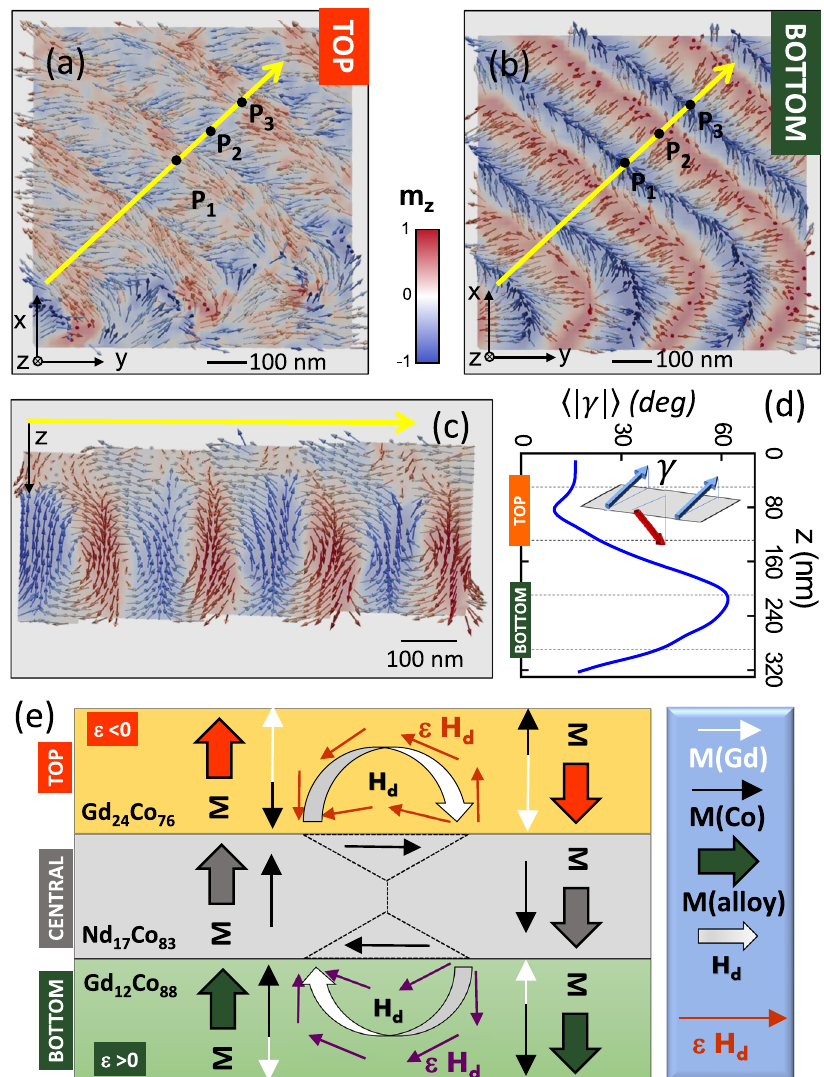
Fig. 3 Vectorial tomographic reconstruction of m(Gd) at MD1 ( m z contrast). a View of the ð x ; y ; 14nm Þ plane (Top Gd-Co layer). b View of the ð x ; y ; 255nm Þ (bottom Gd-Co layer). c Cross-section across yellow arrow in ( a ). Blue/red regions correspond to average up ( þ m Note the reversed m z contrast across the sample thickness. d Pro fi le of average magnetization oscillation across the thickness (measured as j γ j each ð x ; y ; z i Þ plane). Inset shows a sketch of out-of-plane magnetic moment oscillation within a ð x ; y ; z nominal boundaries of Top/Bottom Gd-Co layers. e Sketch of multilayer con fi guration and out-of-plane competing